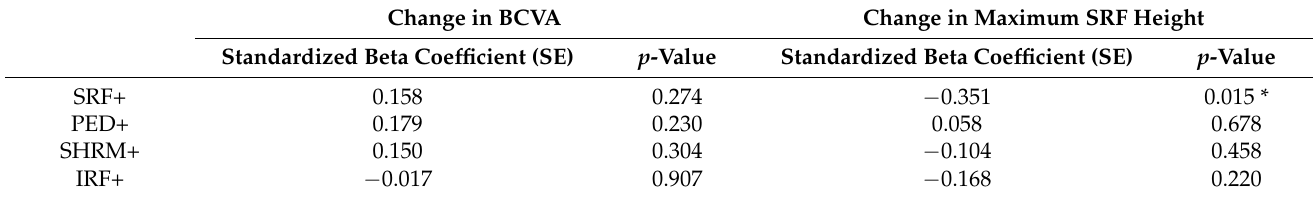
Table 5. Results of multiple regression analysis of the association of changes in BCVA and maximum SRF height at baseline and 6 months’ follow-up (final) with baseline OCT findings. Change in BCVA Change in Maximum SRF